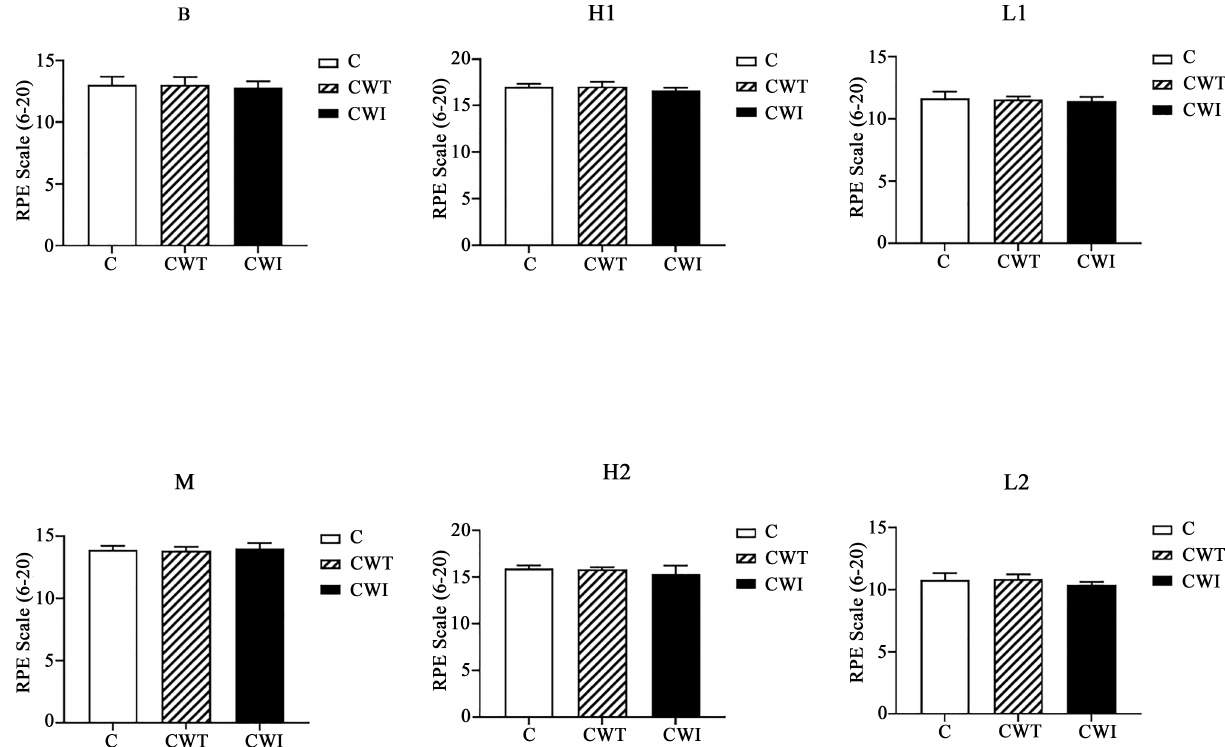
Fig. 3. Serum prostaglandin-2 level in three group. * p < 0.05 represent the difference among C, CWI and CWT at the same time point.